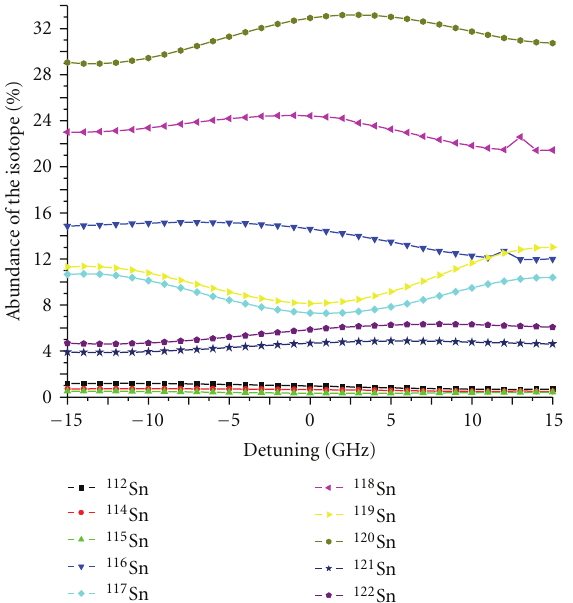
Figure 6: Experimental abundance of the tin isotopes as a function of laser detuning for 286.3317nm transition for a laser linewidth of 1200MHz and a residual Doppler width of 2000MHz.